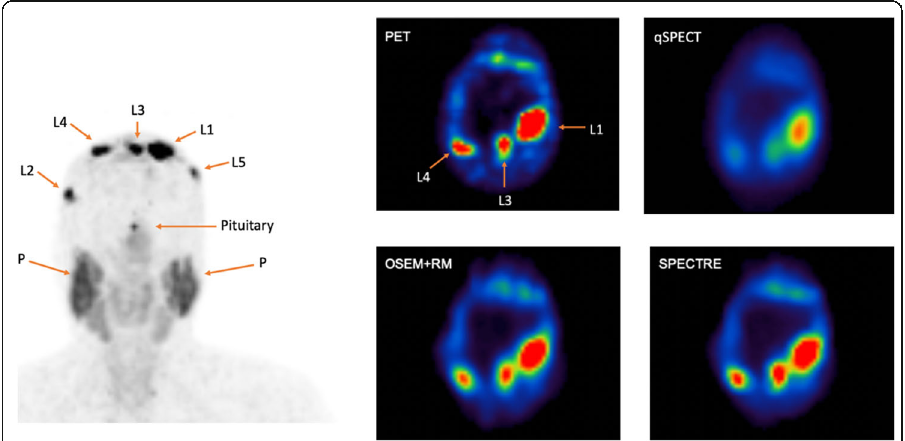
Fig. 4 Left: Maximum intensity projection (MIP) of 4-h 64 Cu-PET head with VOIs labelled. Upper row centre: 64 Cu-PET image (OSEM + RM + 5 mm Gaussian filter): transverse slice showing L1, L3 and L4. The same transverse slice, 67 Cu-SPECT; top right: qSPECT OSEM (4 iterations and 8 subsets), lower row centre: OSEM + RM (40 iterations and 12 subsets), bottom right: SPECTRE with resolution modelling. Abbreviations: L – lesion; P –